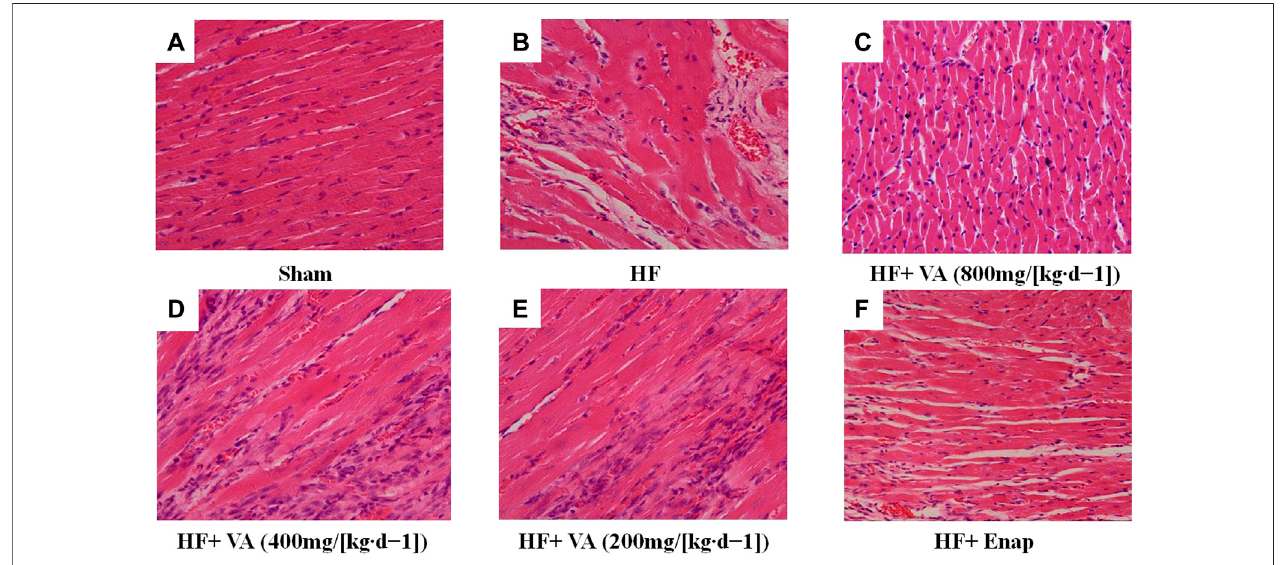
FIGURE 3 | The effect of velvet antlers (VA) on myocardial histology. (A – F) Representative myocardial sections of the sham group (A) , heart failure (HF) group (B) , HF + low dose of VA group (C) , HF + medium dose of VA group (D) , HF + high dose of VA group (E) , and HF + Enap (enalapril) group (F) stained with hematoxylin and eosin (H&E). Bar (cid:1) 50 µm.